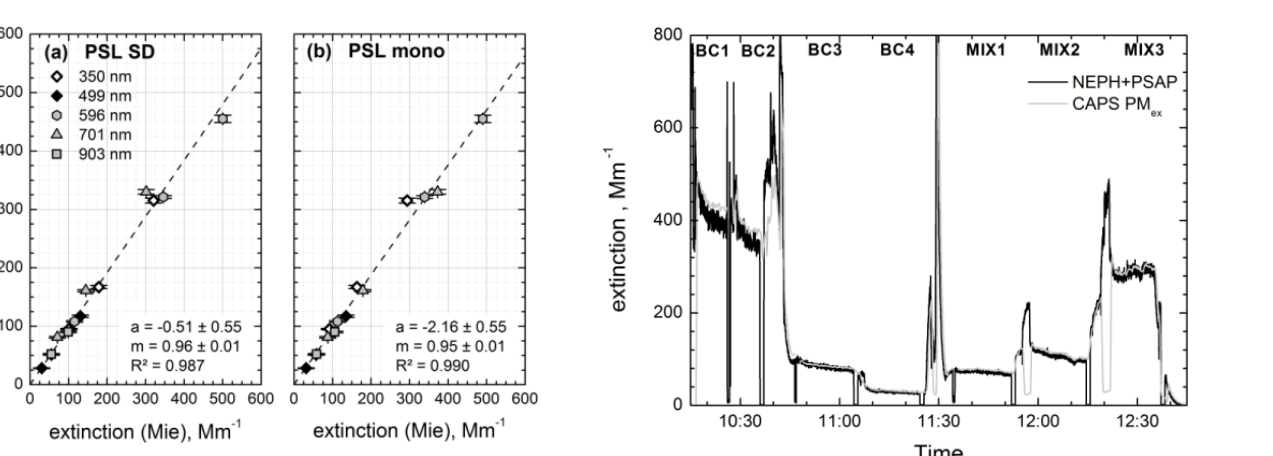
Fig. 6. Time series of CAPS PM ex extinction (black) and NEPH + PSAP extinction (grey) for the laboratory-generated poly- disperse BC and mixed AS + BC experiments; analyzed sequences are labeled at the top